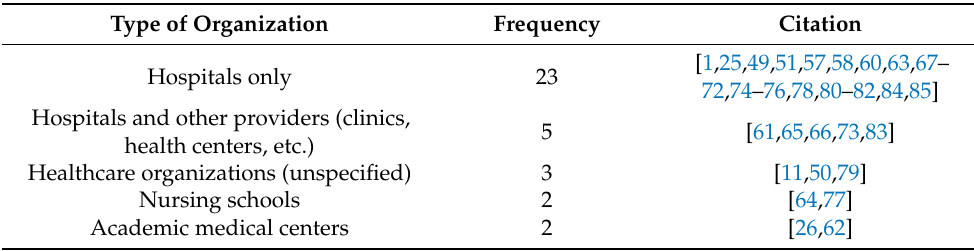
Table 2. Types of organizations involved in the selected